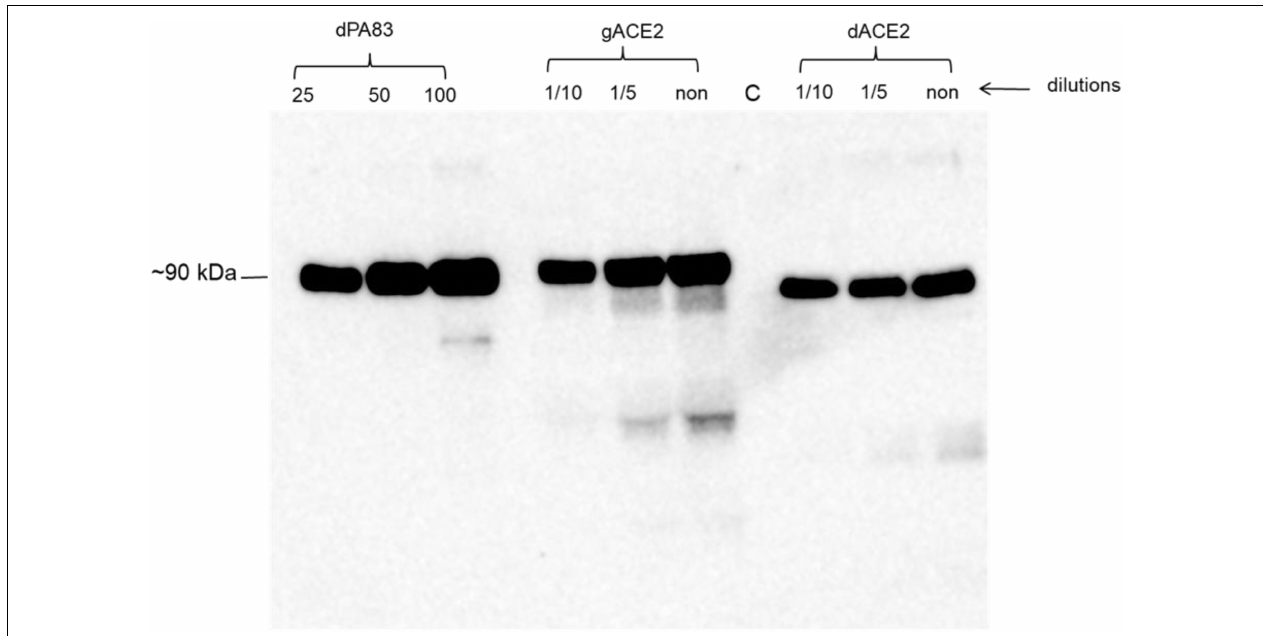
FIGURE 1 | A Western blot analysis of human ACE2s, produced in Nicotiana benthamiana plants. dACE2: angiotensin-converting enzyme 2 (ACE2) co-expressed with bacterial Endo H, produced in N . benthamiana , different concentration (dilutions) of crude extract were loaded into wells ; gACE2: western blot analysis of human ACE2, produced in N . benthamiana plants; different concentration (dilutions) of crude extract were loaded into wells; C-undiluted crude extract from non-infiltrated N . benthamiana, was loaded into well; gPA83: 25, 50, and 100 ng of purified plant produced dPA83 of Bacillus anthracis , loaded as a control protein to quantify the expression levels of ACE2 and ACE2 proteins. Purified anti-His Tag antibody (Cat. No. 652502, BioLegend) was used as primary and mouse IgG used as secondary antibodies to detect ACE2 proteins.